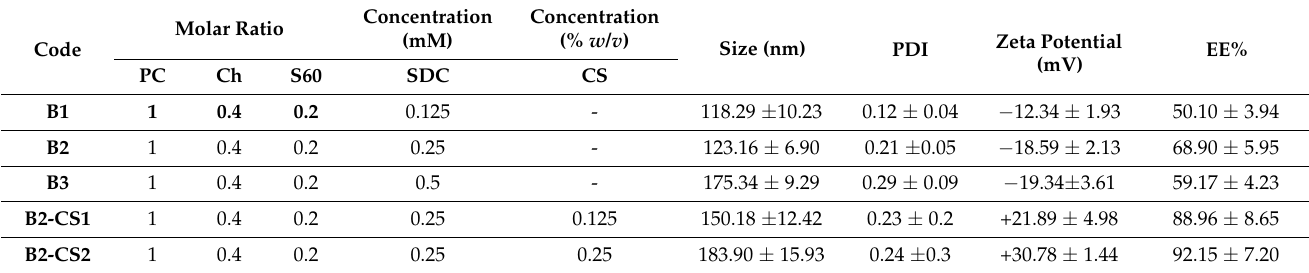
Table 1. The particle size, PDI, zeta-potential, and EE% of different uncoated and chitosan-coated bilosomal formulas. All measurements were carried out in triplicate, and the data are expressed as means ± standard deviations.